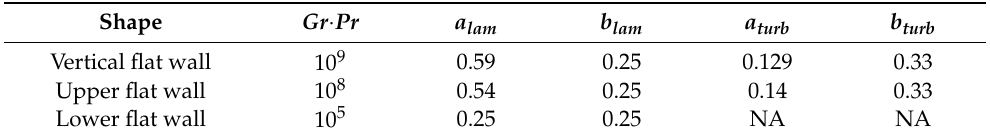
Table 1. Natural convection correlation coefficients [30]; a lam is the value of coefficient a for laminar flow, b lam is the value of coefficient b for laminar flow, a turb is the value of coefficient a for turbulent flow, and b turb is the value of coefficient b for turbulent